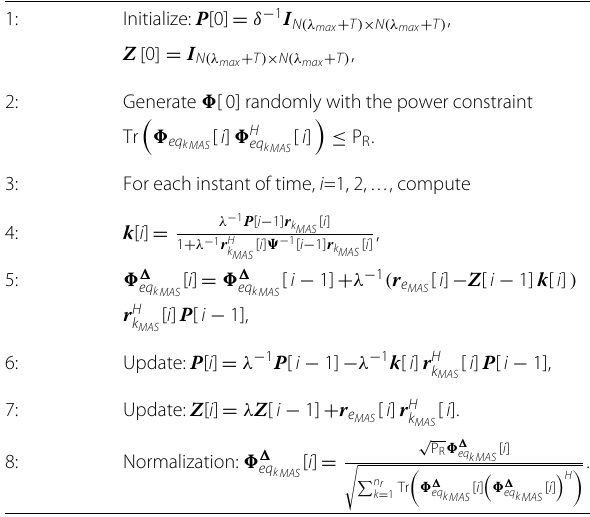
Table 1 Summary of the DT-ACMO RLS algorithm